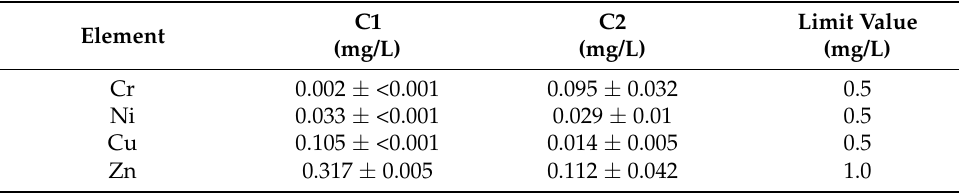
Table 3. Concentrations ± standard deviations of detected minor and trace elements in mg/L in process water: C1 (concentration prior carbonation) and C2 (concentration after carbonation). Limit value according to the German Sewage Water Law.